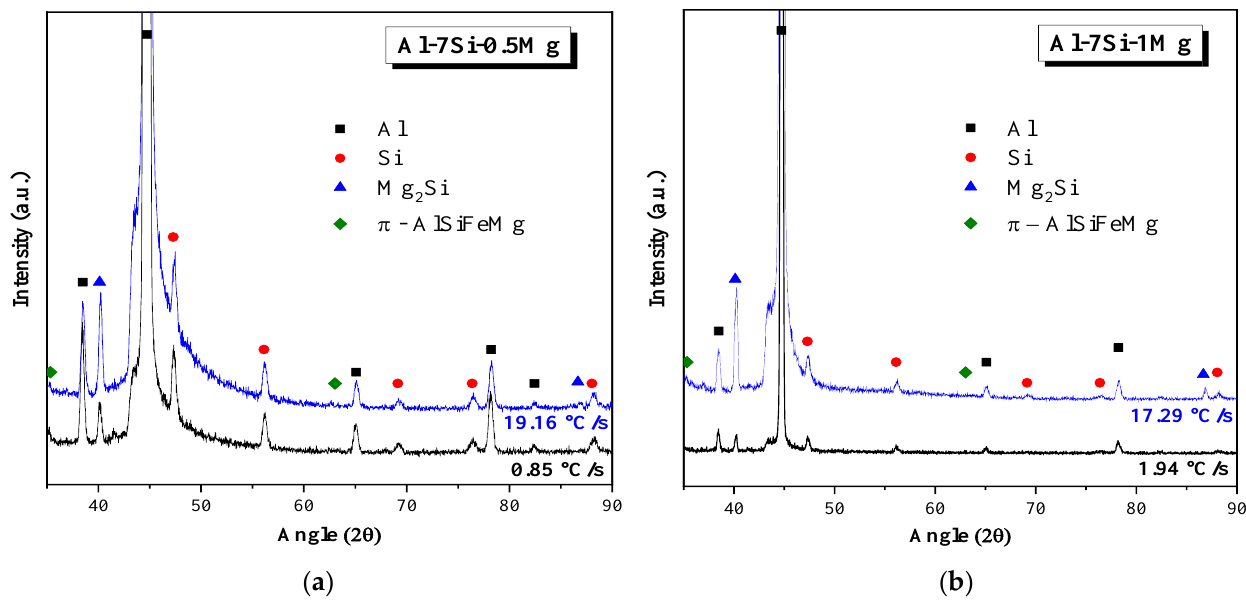
Figure 6. XRD patterns for the ( a ) Al-7Si-0.5Mg and ( b ) Al-7Si-1Mg alloys.